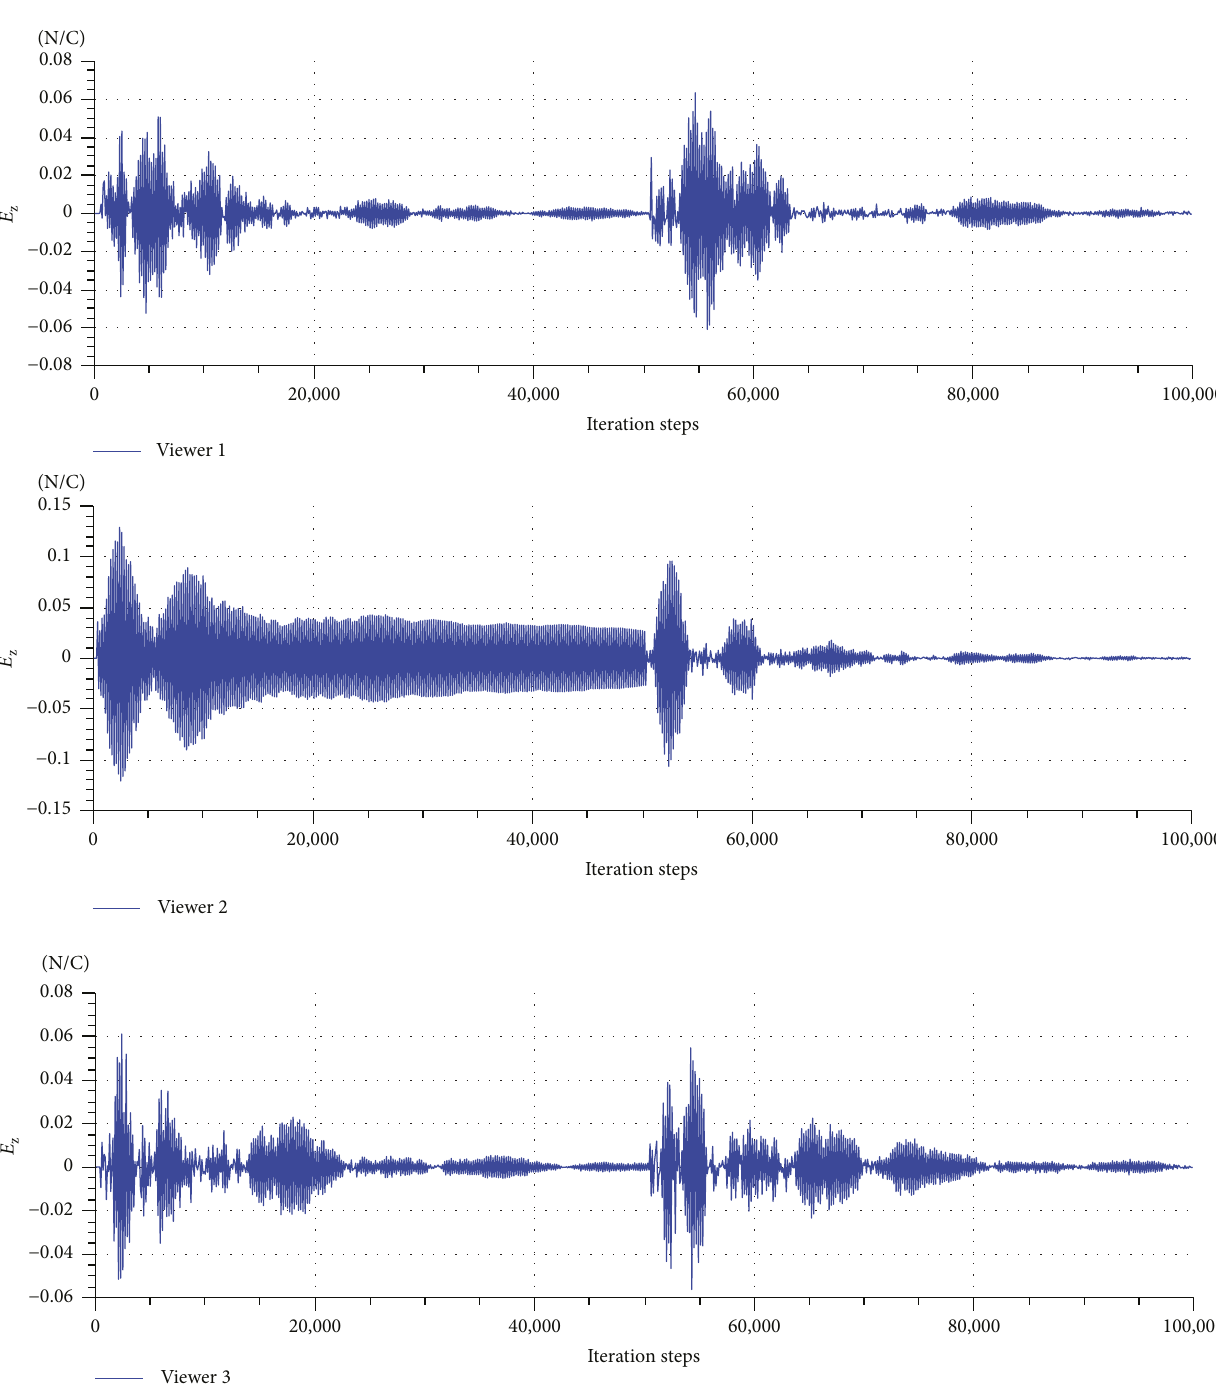
Figure 19: Behaviour of the electric fi eld E